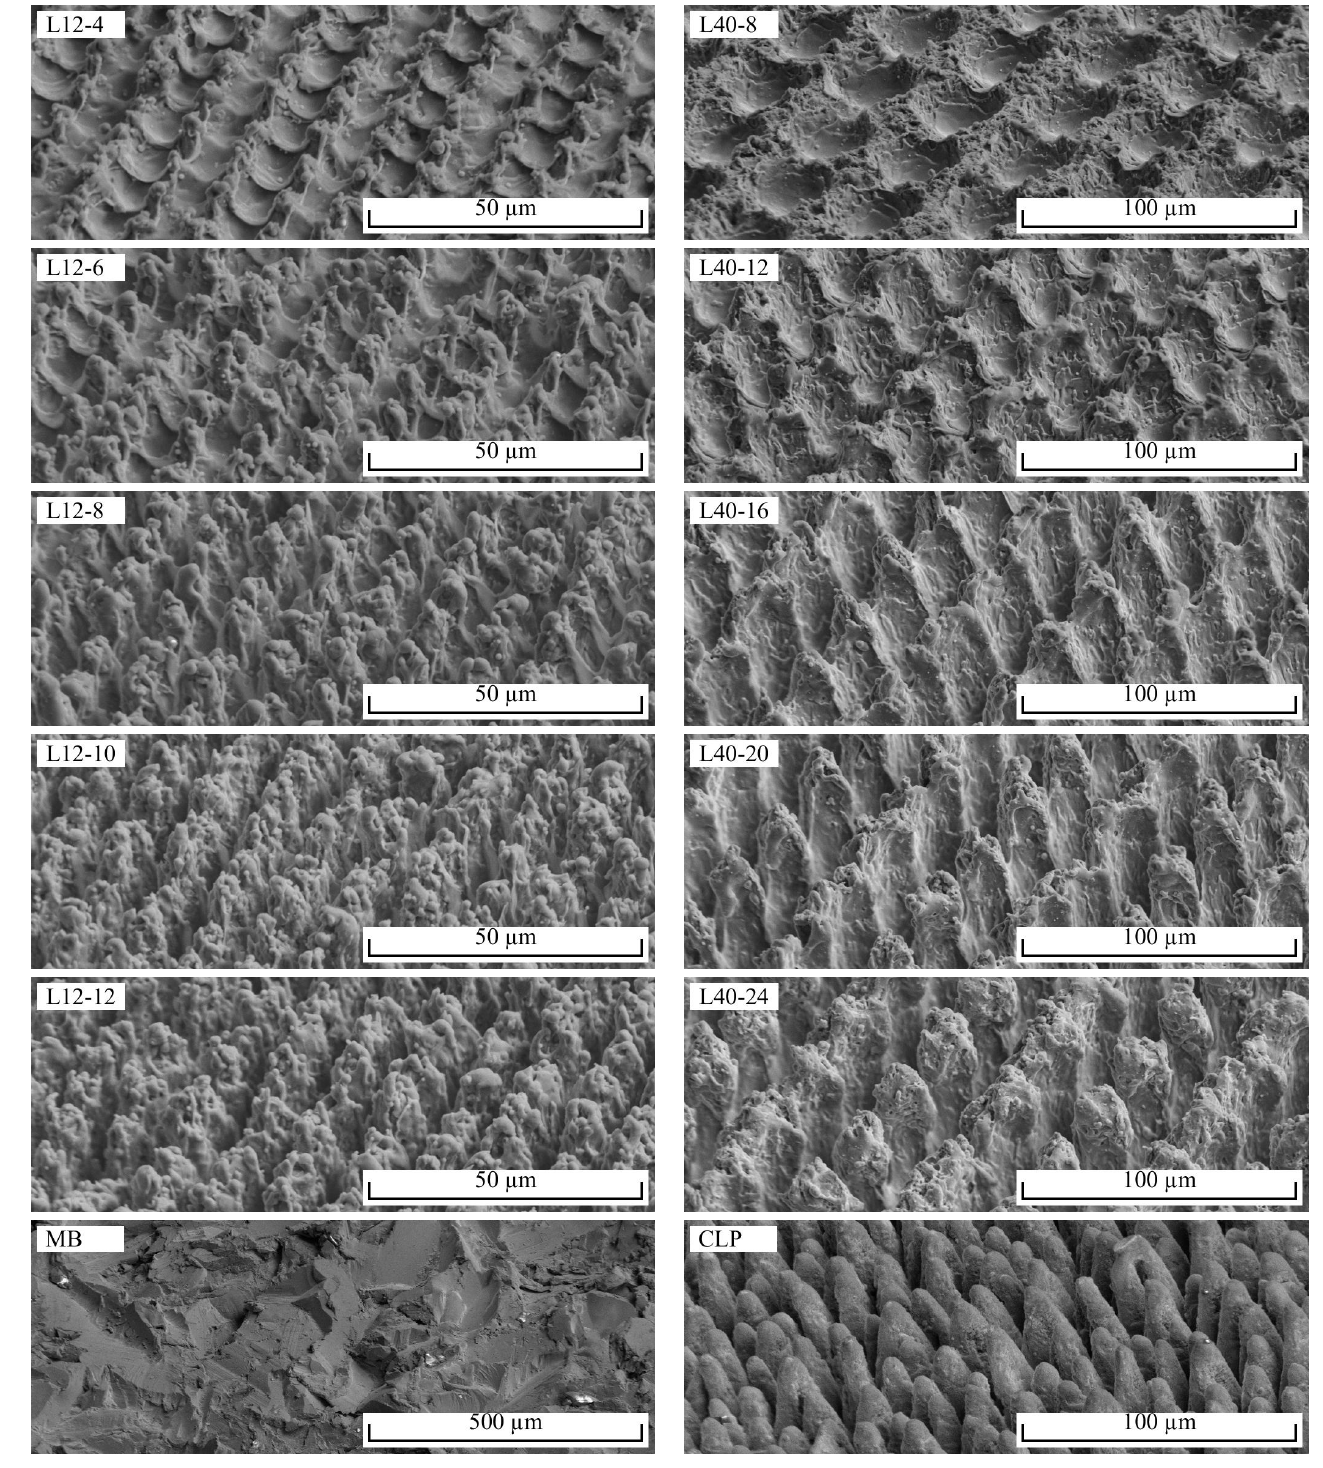
Figure 5. SEM images of all investigated surface structures, stage inclined at an angle of